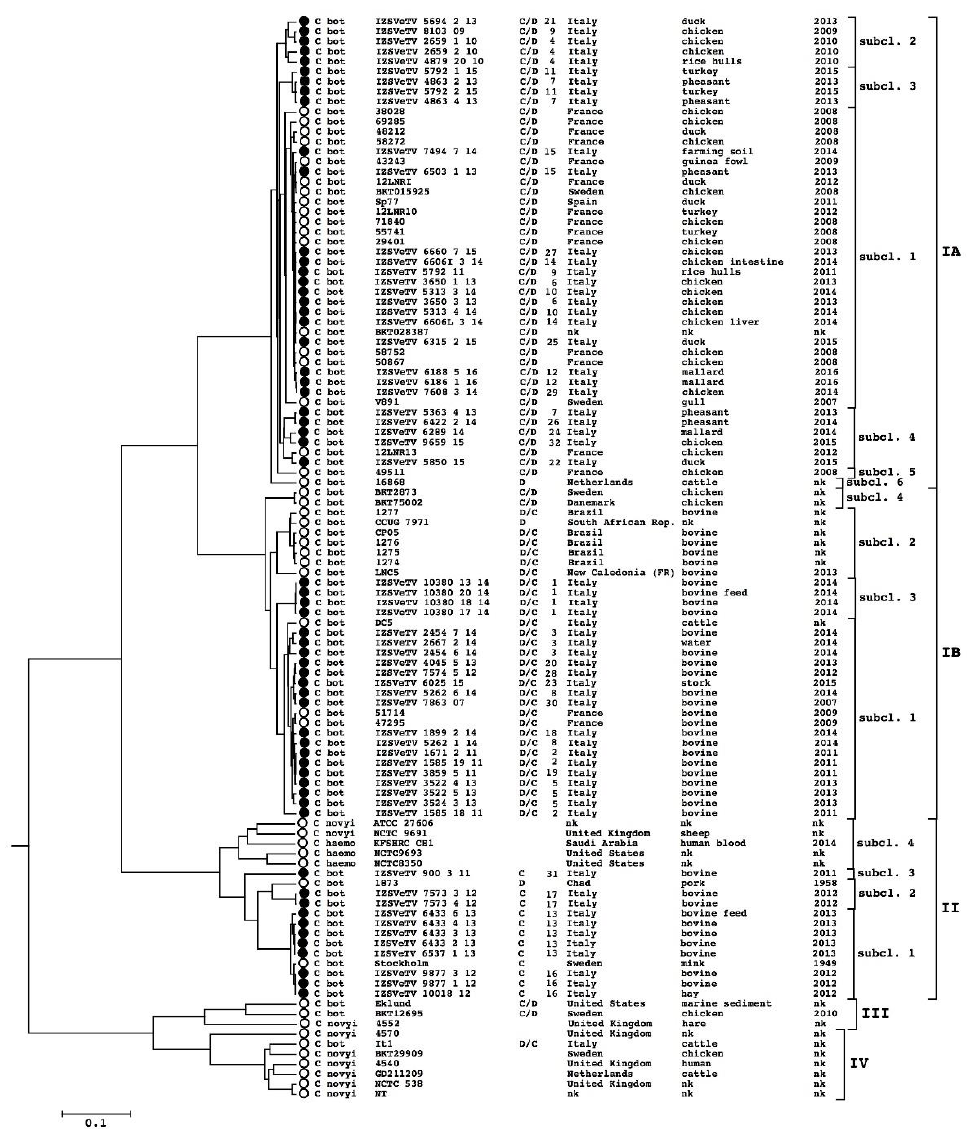
Figure 1. Dendrogram representing the phylogenetic relations among the analyzed strains, as calculated using Gegenees software. The new sequenced genomes are marked with black dots while the genomes already analyzed in previous studies are marked with white dots. For each sample, the information shown in the Figure are, from left to right: species, sample name, serotype, outbreak ID, geographical origin, isolation source, isolation year.